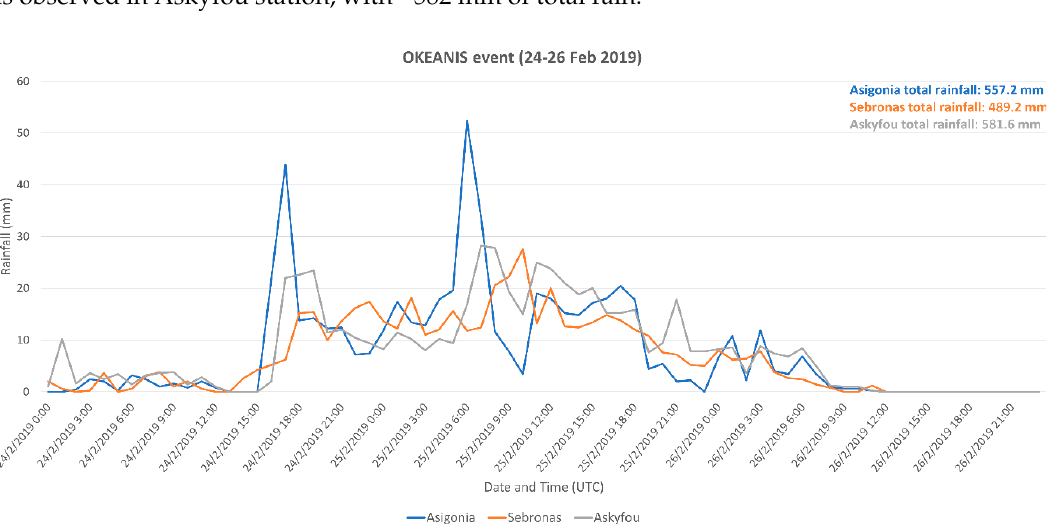
Figure 8. Time evolution of observed 1-h accumulated rainfall during the 3-day period, starting at 0000 UTC 24 February 2019. Data are shown for 3 automatic stations located at mid-level heights in the western part of (Asi Gonia (AG), Sebronas (SB), and Askyfou (AS)). The total amount of rainfall recorded during the event is shown in the upper-right corner.